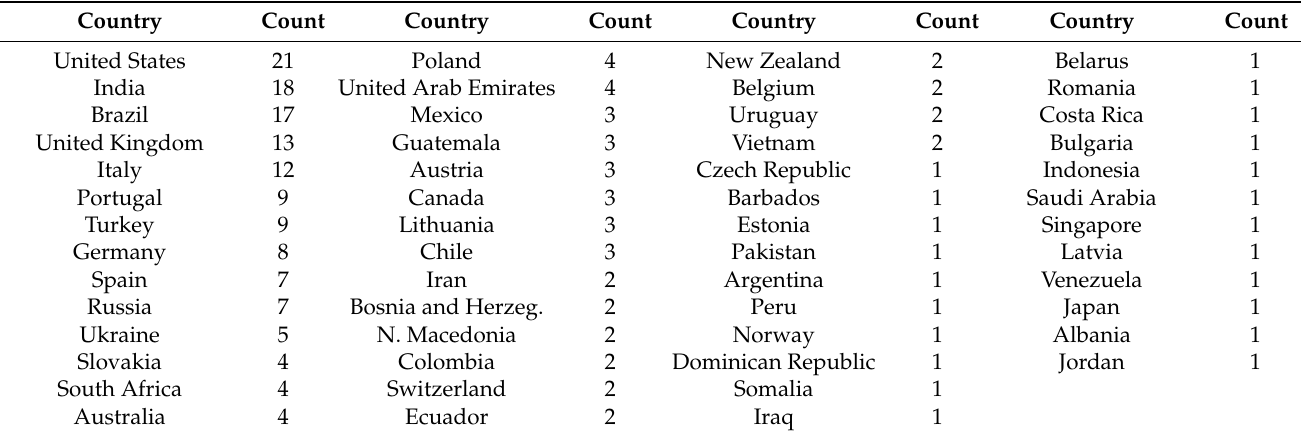
Table 1. Country of